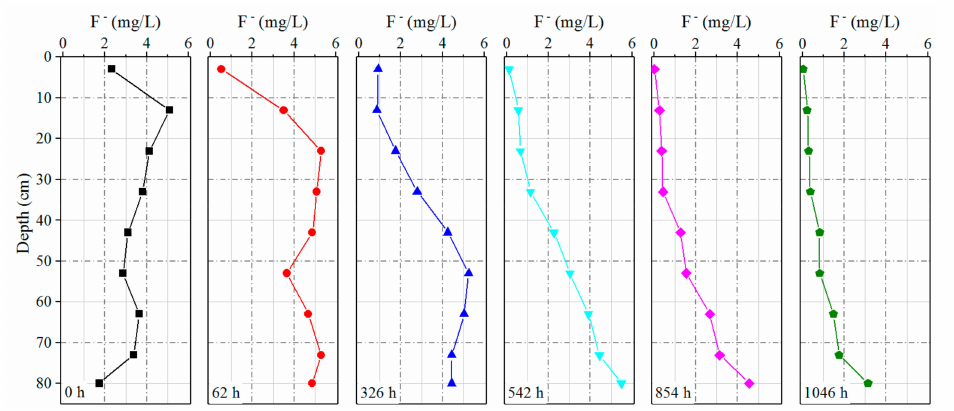
Figure 11. F − concentration of the soil solution in the soil column of a soil column leaching experiment.